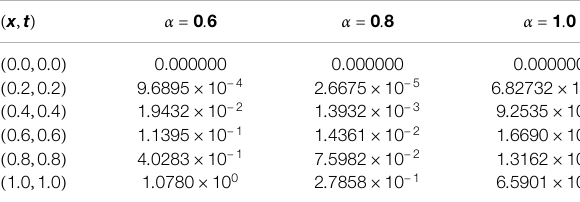
( x , t ) for different values of α 7